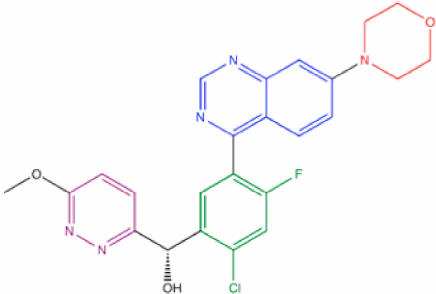
Figure 13. Structure of M3814. Red: morpholine group, blue: quinazoline group, green: chloro- fluorobenzene group, violet: pyridazine